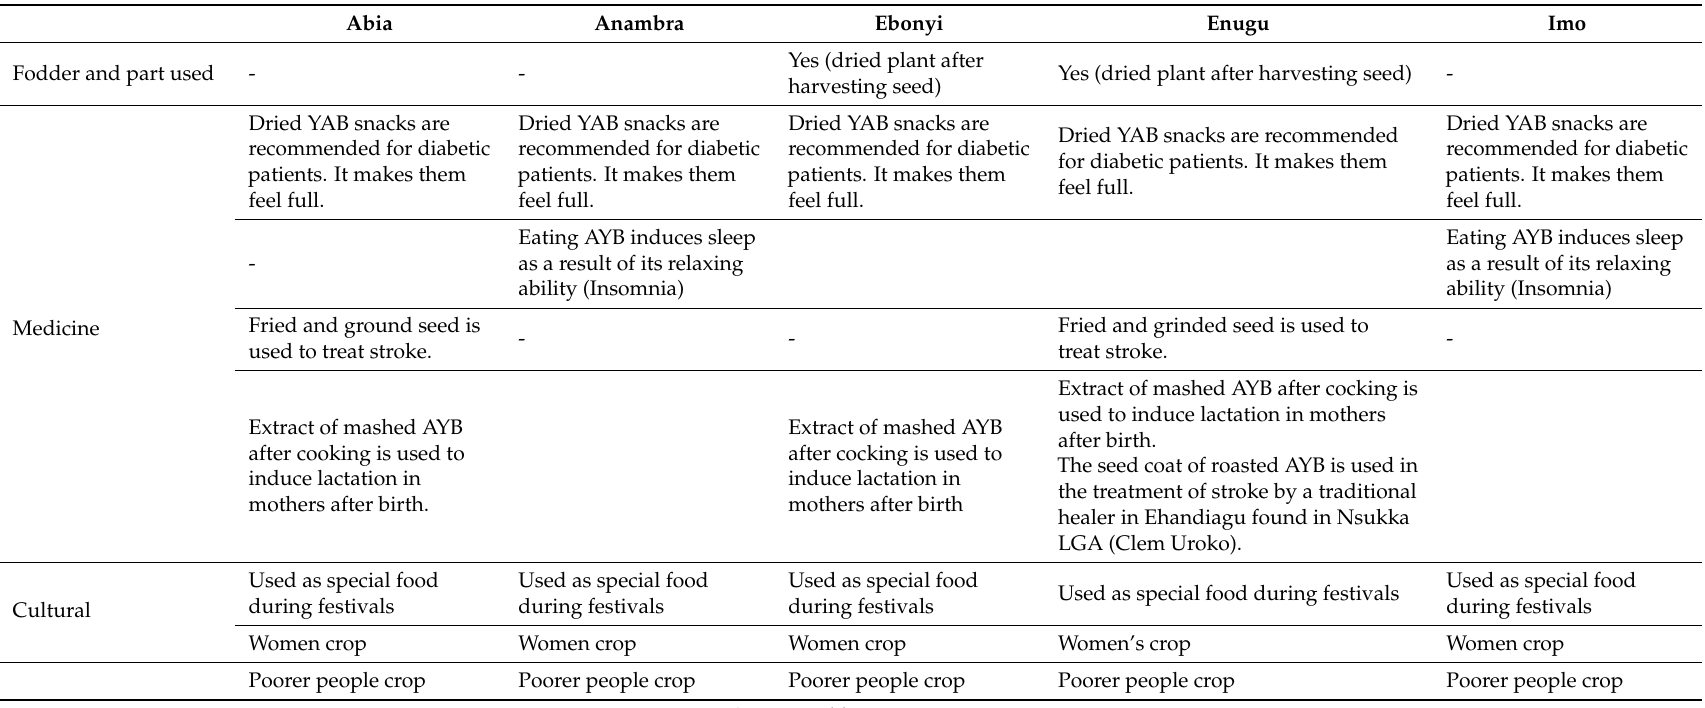
Table 1. Other uses of African Yam Bean in the five states of southeastern